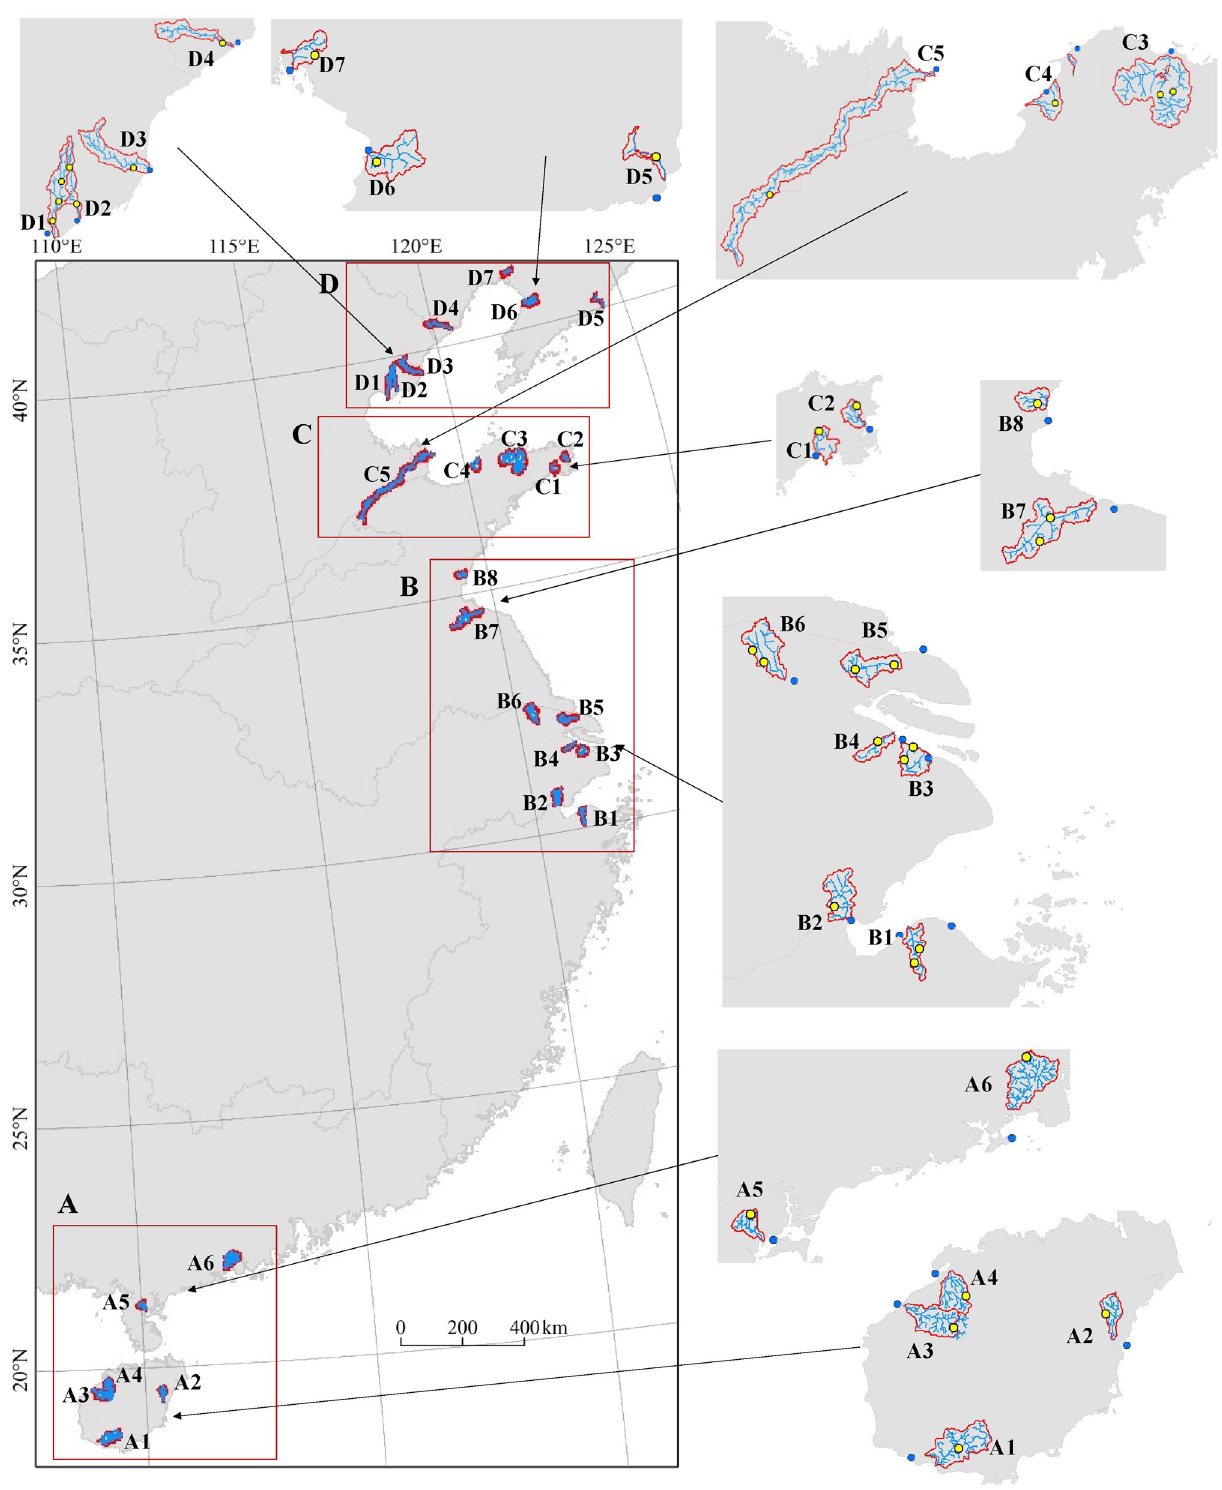
Fig. 1 Location and area of 26 catchments along the Chinese coast- line (blue dots represent tide gauges and yellow dots represent rainfall gauges). Label A refers to the region in southern China with a latitude of lower than 21.5°. Catchments labeled as B are located on the east-